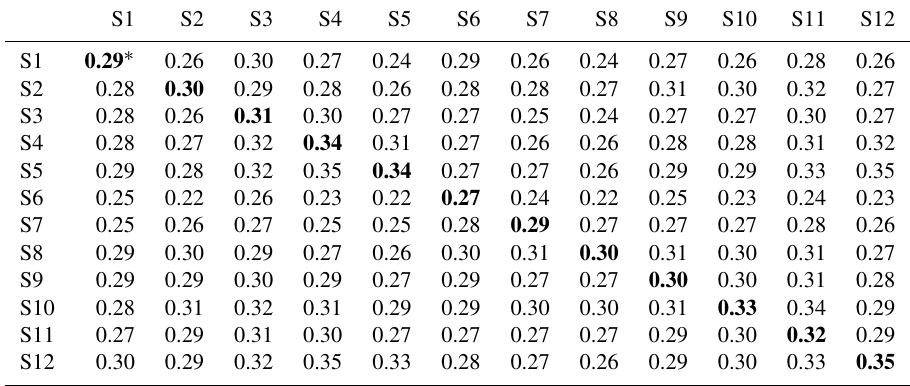
Table 7. Lag-1 cross-correlation of observed data for 12 stations from the Yeongnam province, South Korea.